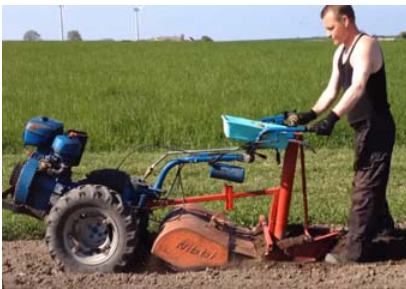
Figure 14. Artificial assisted seed delivery planter. Reprinted with permission from ref. [48] . Cop- yright 2020 Google.